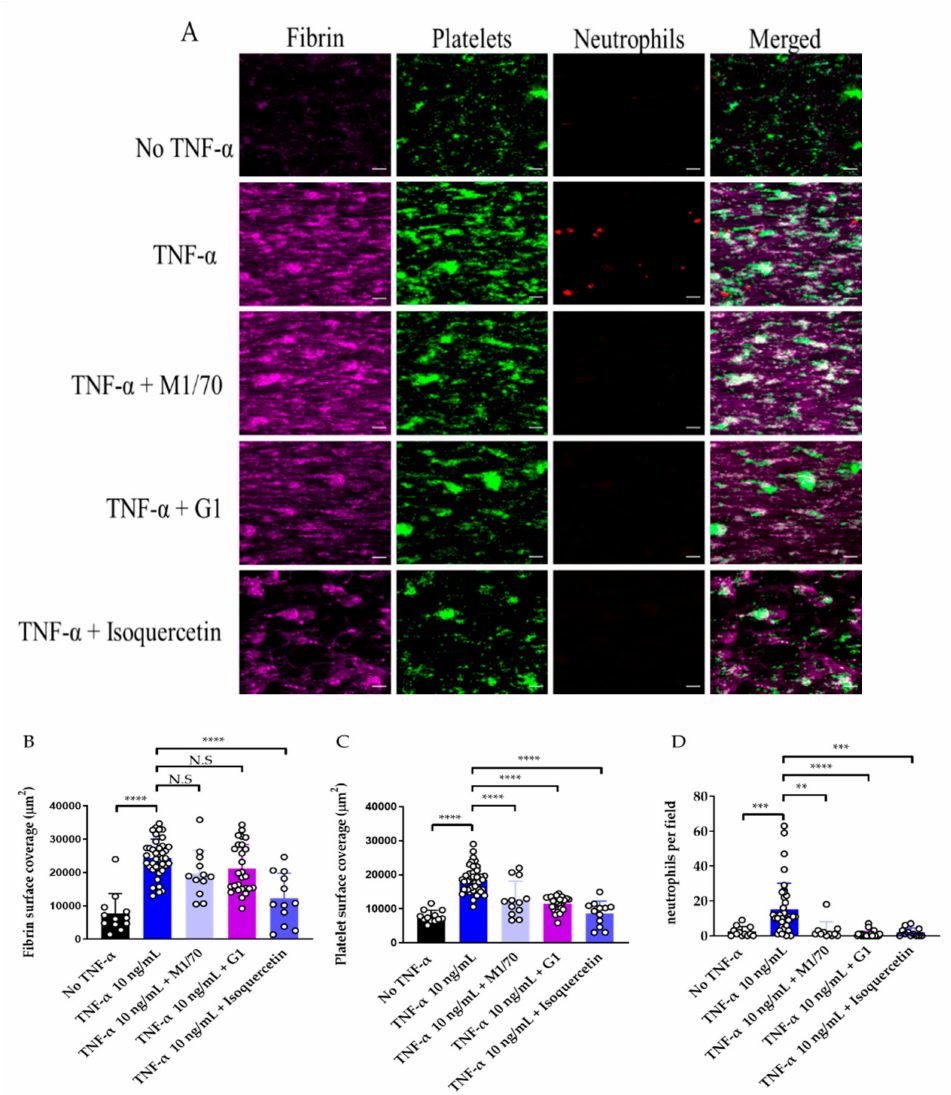
Figure 8. Effect of anti-inflammatory agents on thromboinflammation. ( A ). Representative images of fibrin (magenta), platelets (green), and neutrophils (red) on endothelialized chips. Endothelial cells were treated with tumour necrosis factor alpha (“TNF- α ”) or without TNF- α (“No- TNF- α ”). Whole blood was incubated with M1/70 (inhibitory antibody to Mac-1), G1 (inhibitory antibody to P-selectin) and isoquercetin. Scale bar represents 20 µ m. ( B ). Fibrin, ( C ). platelet surface coverage and ( D ). neutrophils per x40 field in No TNF- α (black columns), TNF- α (dark blue columns), TNF- α in the presence of M1/0 (violet columns), TNF- α in the presence of G1 (magenta columns) and TNF- α in the presence of isoquercetin (light blue columns). Data represents mean ± SD of 3-9 fields of view per donor, n = 4–6. ** p < 0.01; *** p < 0.001; **** p < 0.0001, N.S = non-significant by one-way ANOVA with Dunnett’s post-hoc multiple